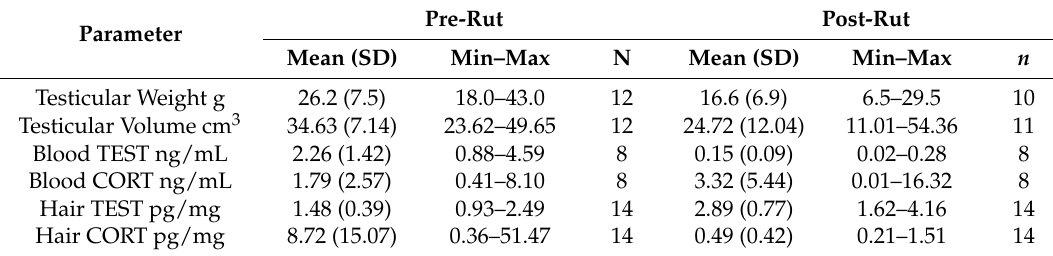
Table 1. Descriptive statistics of the analyzed parameters for both pre- and post-rut